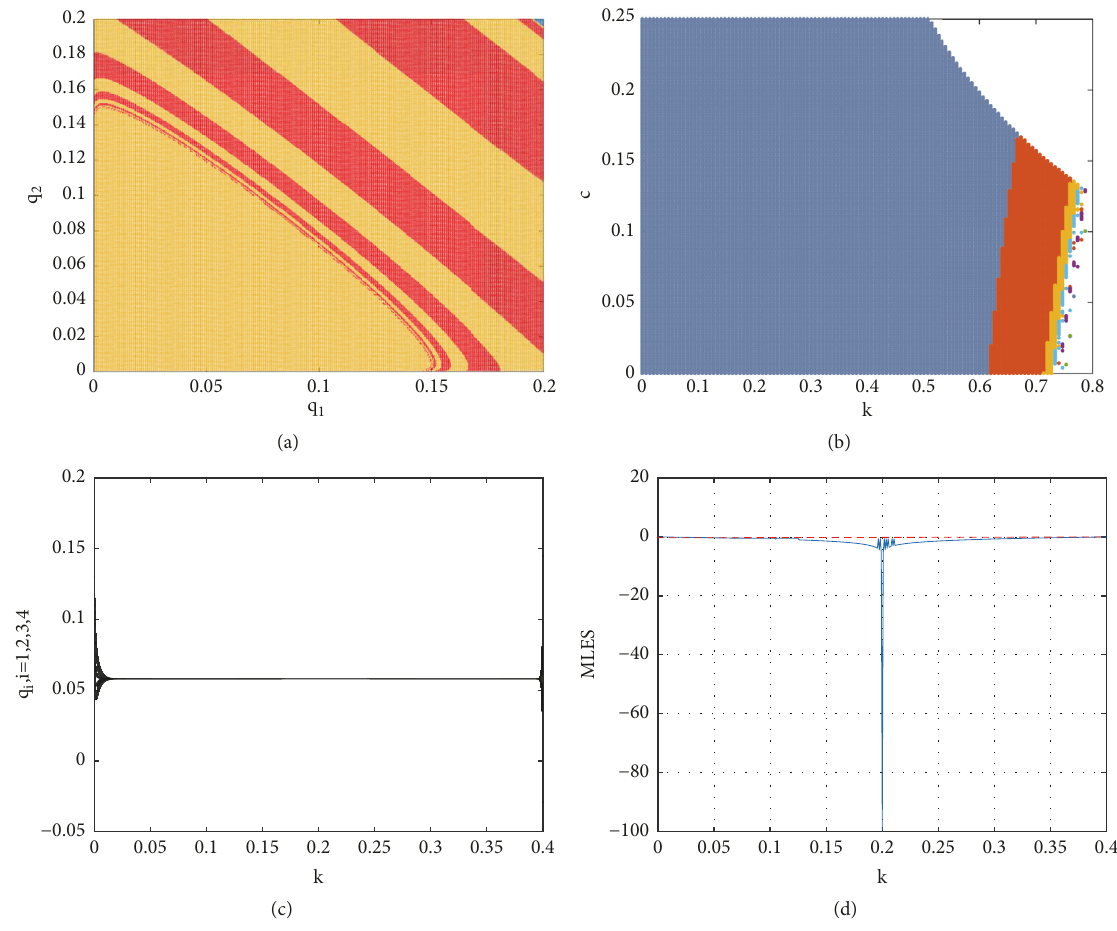
Figure 5: (a) The basin of attraction of the period 4-cycle at (𝑎,𝑐,𝑘,𝛼,𝑞 3 , 𝑞 4 ) = (0.625, 0.11, 0.75, 0.75, 0.13, 0.11) . (b) 2D bifurcation in the (𝑘, 𝑐) parameter plane at (𝑎, 𝛼,𝑞 0,1 , 𝑞 0,2 , 𝑞 0,3 ,𝑞 0,4 ) = (0.625, 0.75, 0.19, 0.15, 0.13, 0.11) . (c) Bifurcation diagram of system (6) with respect to 𝑘 at (𝑎,𝑐,𝛼,𝑞 0,1 , 𝑞 0,2 , 𝑞 0,3 ,𝑞 0,4 ) = (0.4, 0.11, 1,0.19, 0.15, 0.13, 0.11) . (d) Maximum Lyapunov exponents with respect to 𝑘 at (𝑎,𝑐,𝛼,𝑞 ,𝑞 , 𝑞 , 𝑞 ) = (0.4, 0.11, 1, 0.19, 0.15, 0.13, 0.11) 0,1 0,2 0,3 0,4